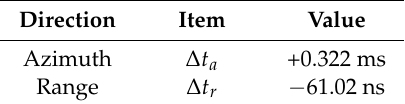
Table 3. Geometric calibration parameters of Gaofen-3 solved by cross-calibration.